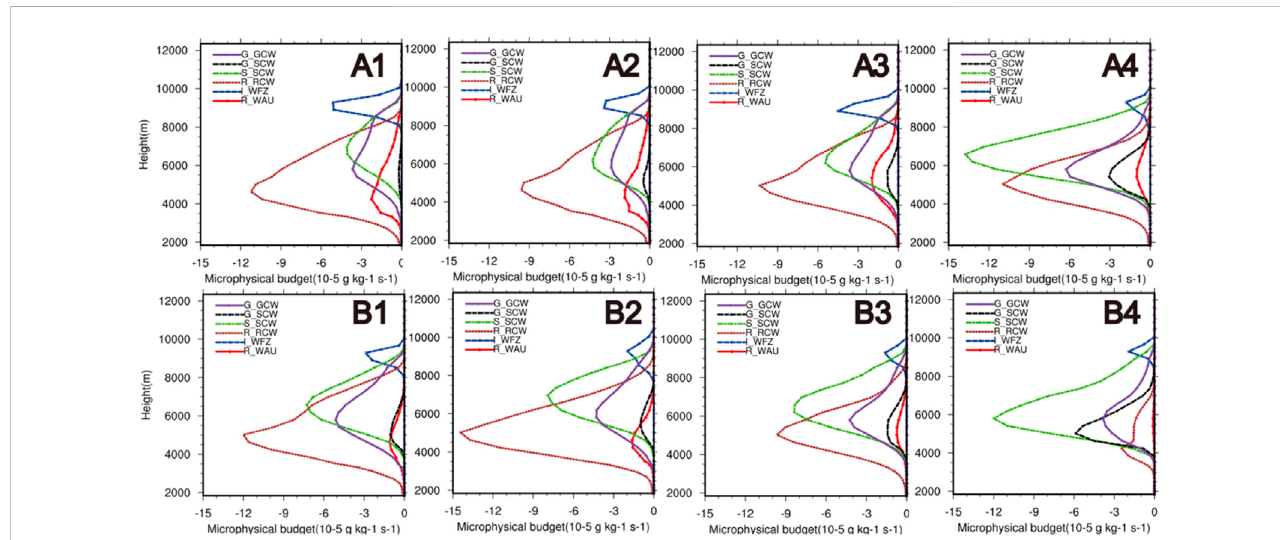
FIGURE 12 Height distribution of microphysical budget of cloud particles at 0930 UTC (Unit: 10 – − 5 g kg − 1 s − 1 ): (A) TH-AU (B) MY-AU; (1) NCCN50 (2) NCCN200 (3) NCCN 2000 (4) NCCN10000; G_GCW is the riming of graupel particles to cloud drops, G_SCW is the snow crystal s rime cloud droplets to generate graupel particles, S_SCW is the snow crystals rime cloud droplets to generate snow particles, R_RCW is the collision-coalescence of rain to cloud, I_WRF is the cloud droplets freeze into ice crystals, R_WAU is the cloud to rain auto-conversion.